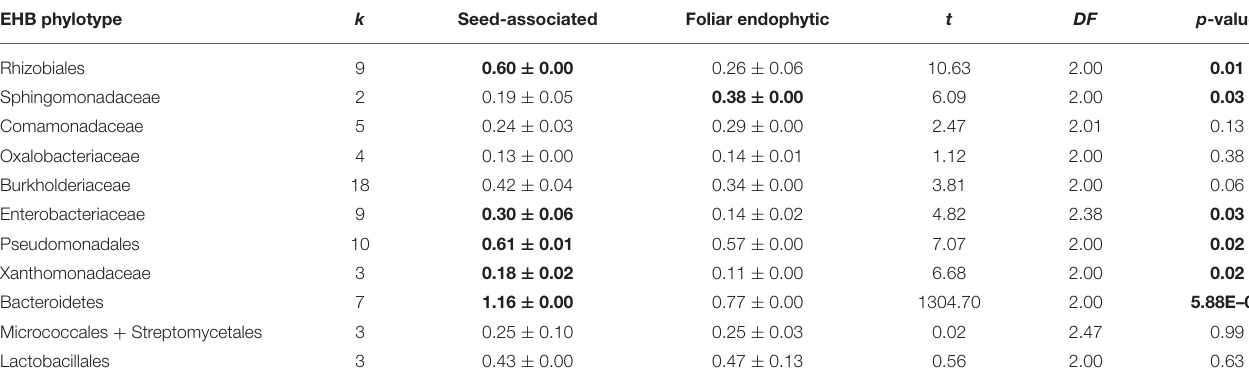
TABLE 2 | Phylogenetic diversity ( PD ) among EHB of tropical seed-associated and foliar endophytic fungi. EHB phylotype k